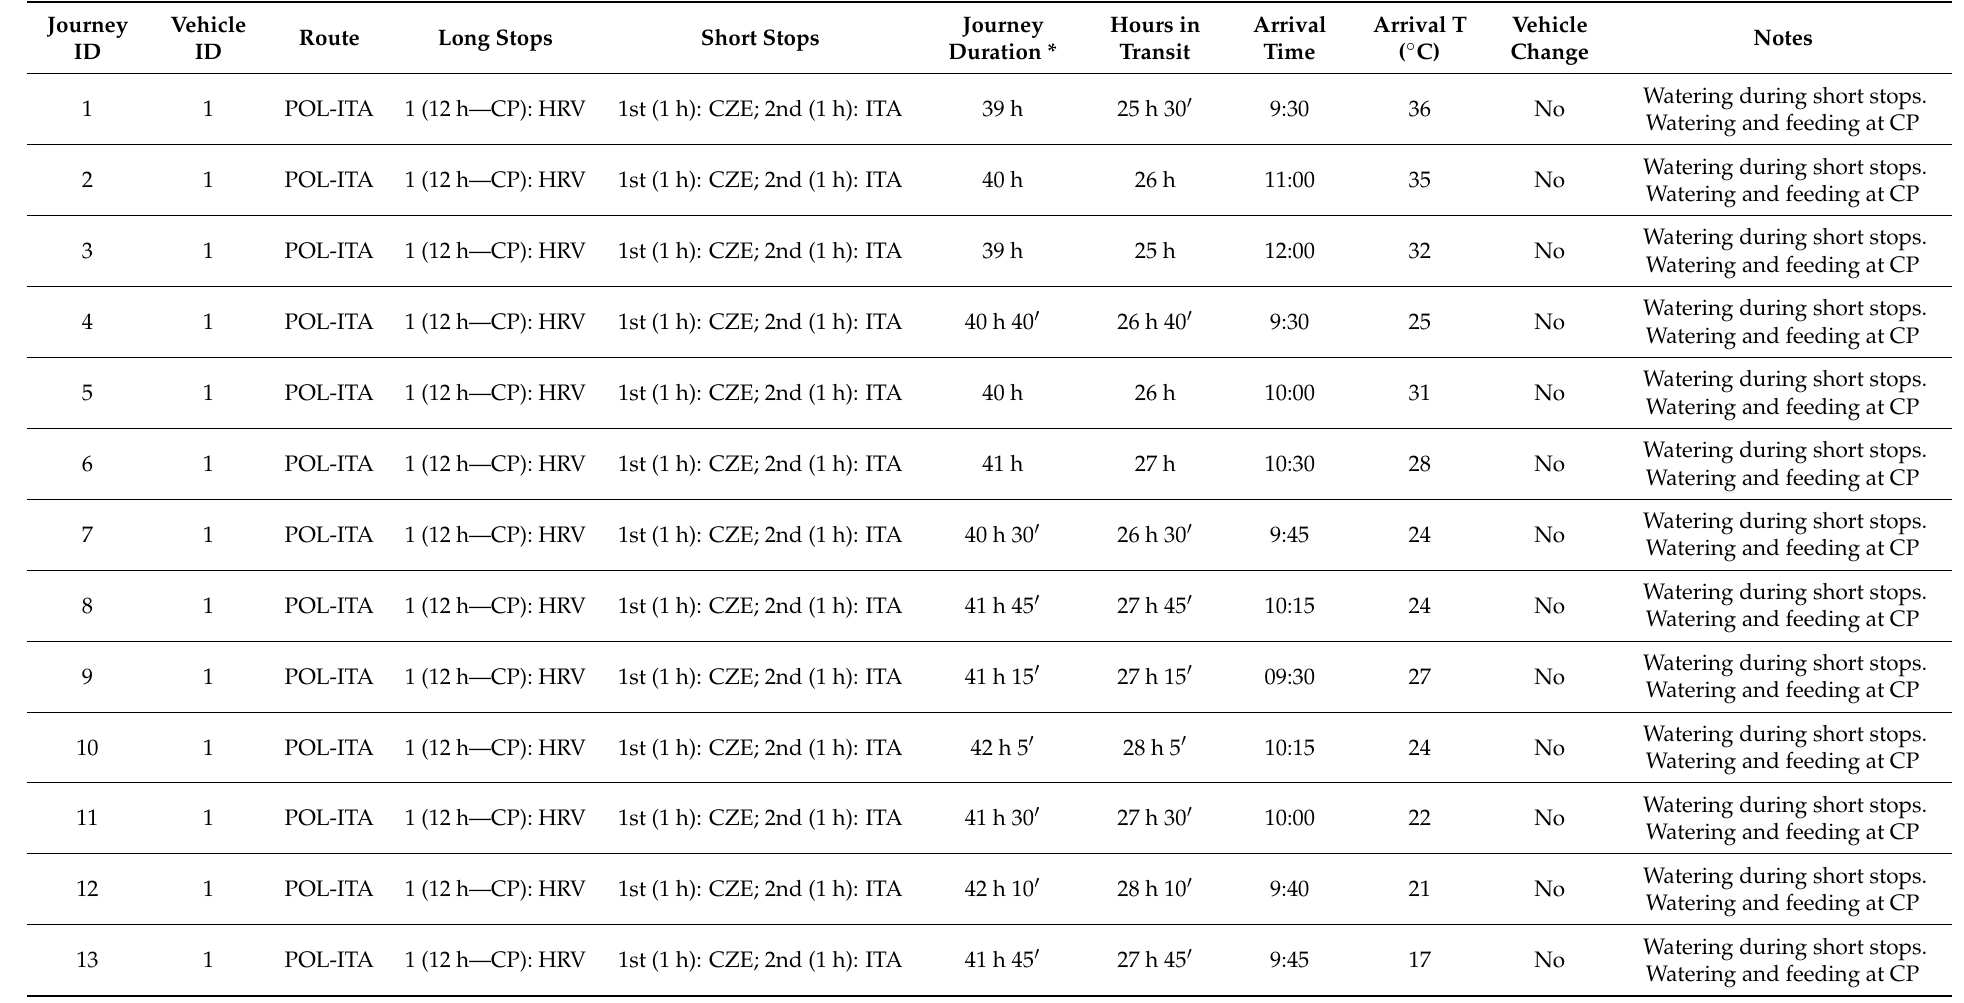
Table 4. Routes, long and short stops (duration and location), total journey duration, transit stage duration, arrival time and temperature (T), and change of vehicle for each assessed